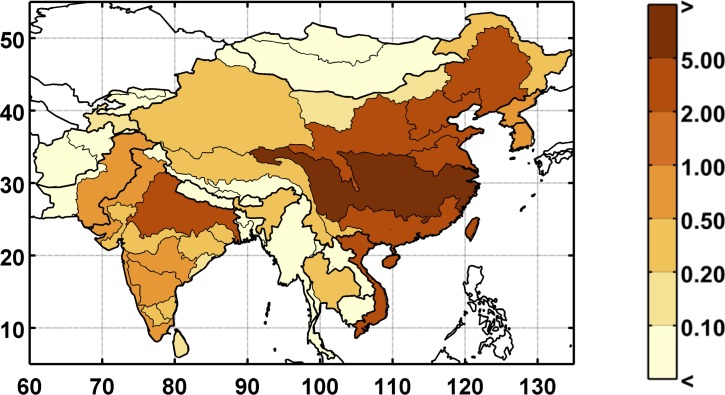
Baseline industrial water requirement (in billion cubic meters).